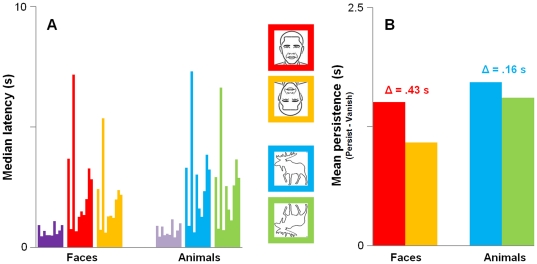
Behavioral results.(A) Median button-press latencies for ten subjects; individual's medians are clustered by condition. Colors correspond to icons for the Persist conditions (red = upright faces; yellow = inverted faces; blue = upright animals; green = inverted animals) and Vanish conditions are purple (no icon; dark purple = Vanishfaces and light purple = Vanishanimals). Latencies were always longer for Persist compared to Vanish. All subjects had longer latencies for upright faces compared to inverted faces; eight of the ten subjects also showed this pattern for animals. (B) Mean behavioral persistence computed as the difference between individual's median latencies for the Persist (animals or faces) and Vanish conditions, each matched by category (red = upright faces; yellow = inverted faces; blue = upright animals; green = inverted animals). The effect of inversion on persistence (Δ) was significant for both faces and animals (p<.05).